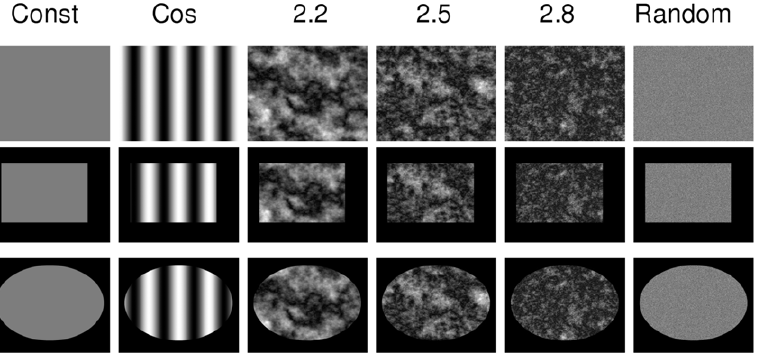
Figure 1. Six sample images. A An image with constant gray value, an image with cosine shaped varying gray levels in the horizontal direction and constant gray value in the vertical direction, three images with varying gray levels but distinct predefined fractal dimensions and finally an image with random gray values. B Same six images as in A, but with a rectangular region of interest (ROI). C Same six images as in A, but with an elliptical